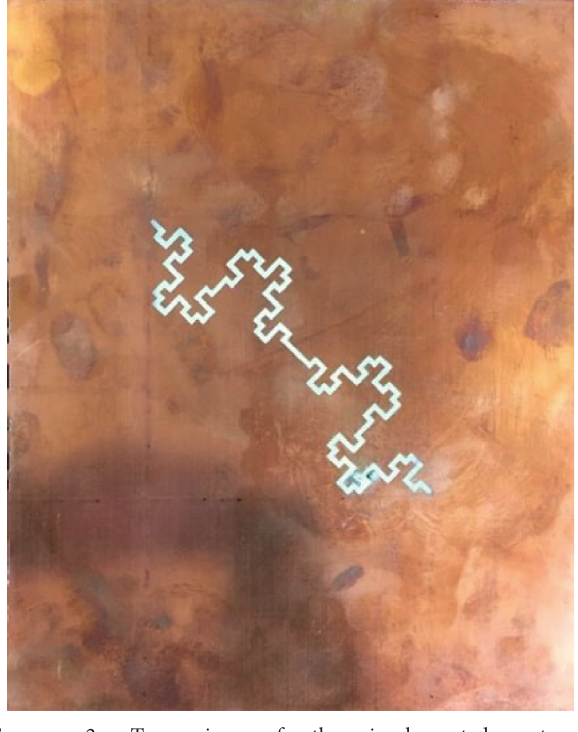
Figure 2: Top view of the implemented antenna (20.4 cm ×